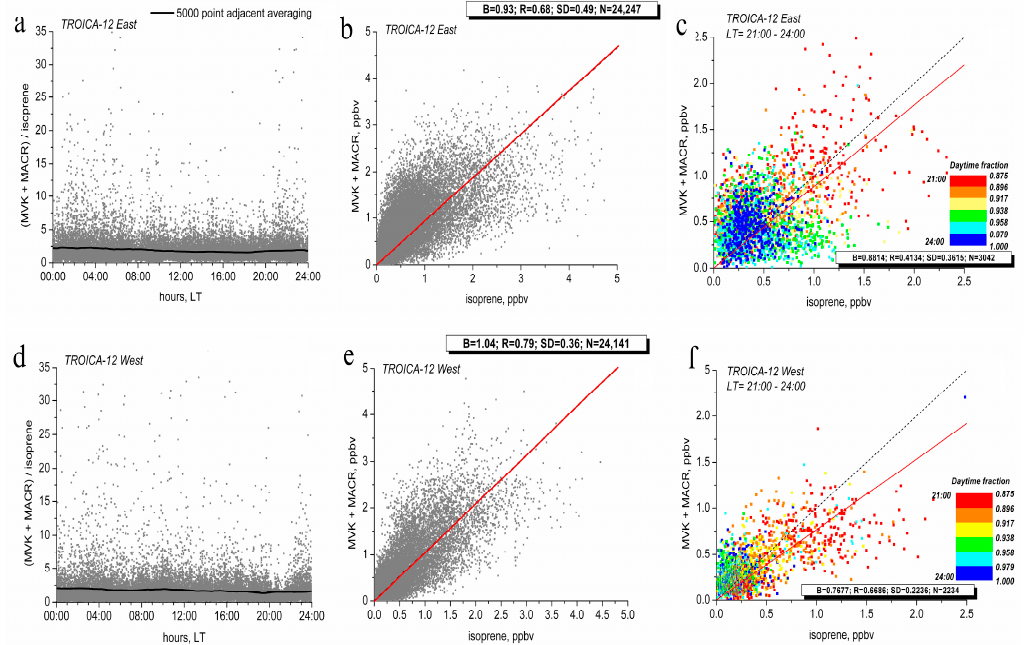
Figure 7. The diurnal variations of the ratio, obtained from TROICA-12 East and West measurements, are shown in ( a , d ). The linear regressions based on measurements along the Far-East stage of the railroad are presented in ( b , e ). The discussed problematical nocturnal linear regressions in the twilight were coloured in ( c , f ) in the range of 21:00–24:00 LT, with a 30-min step. The corresponding daytime fraction is equal to 0.875–1.0, (red–blue colour). Red lines correspond to linear regressions. The dashed lines correspond to the ratio of 1:1.